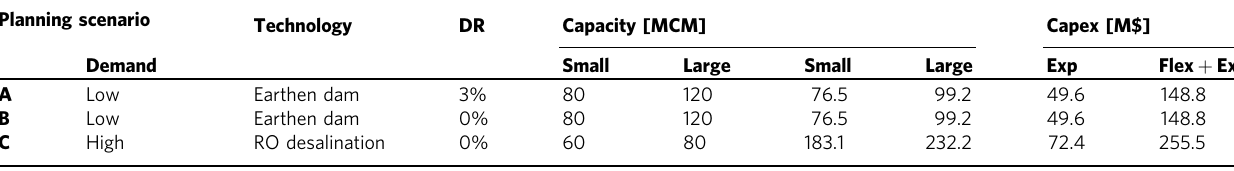
Table 1 Planning scenario de fi nitions Planning